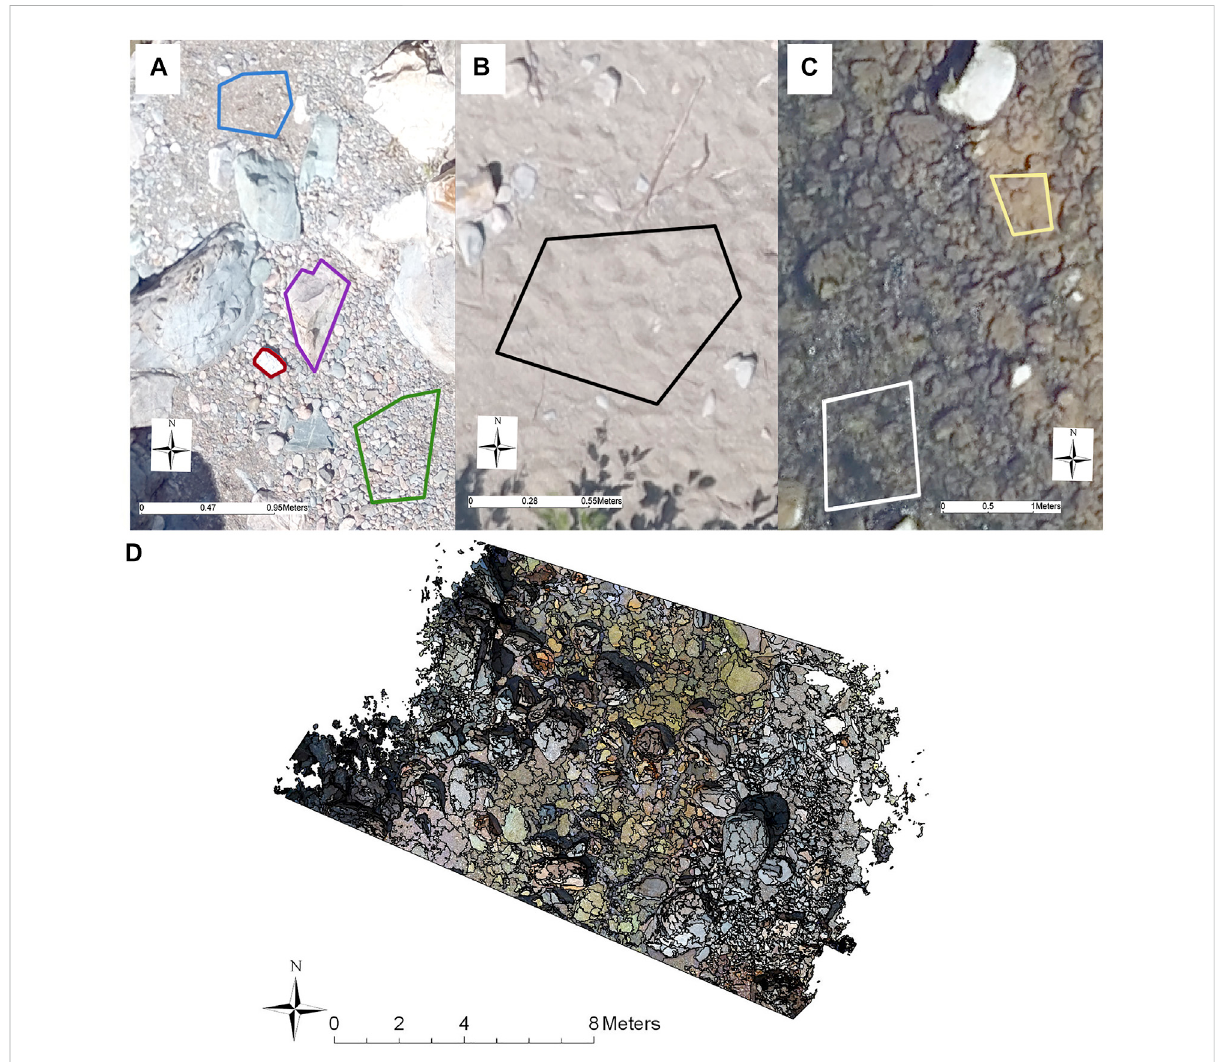
FIGURE 5 Anexampleofgroundcoversamplesusedastrainingsitesinthesupervisedclassi fi cationofsubstrateinbothdryandsubmergedenvironments. (A) purple(largeboulders),red(boulders),green(gravel),blue( fi negravel). (B) black(sand). (C) white(othervegetation),yellow(silt). (D) Anexampleof the segmentation results, overlayed on top of the dry/submerged image for transect